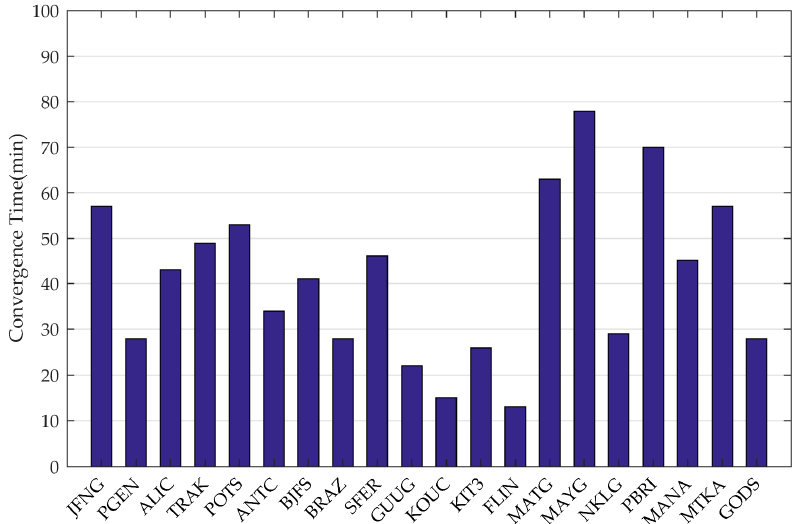
Figure 11. The convergence time for the 20 global distributed IGS stations.